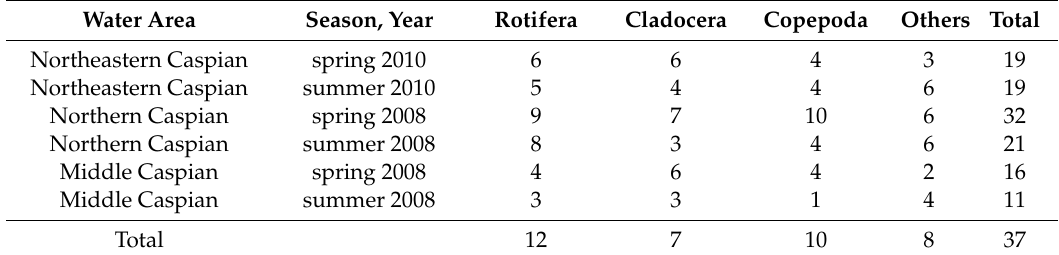
Table 2. Species richness of zooplankton communities in the surveyed water area of the Caspian Sea. Water